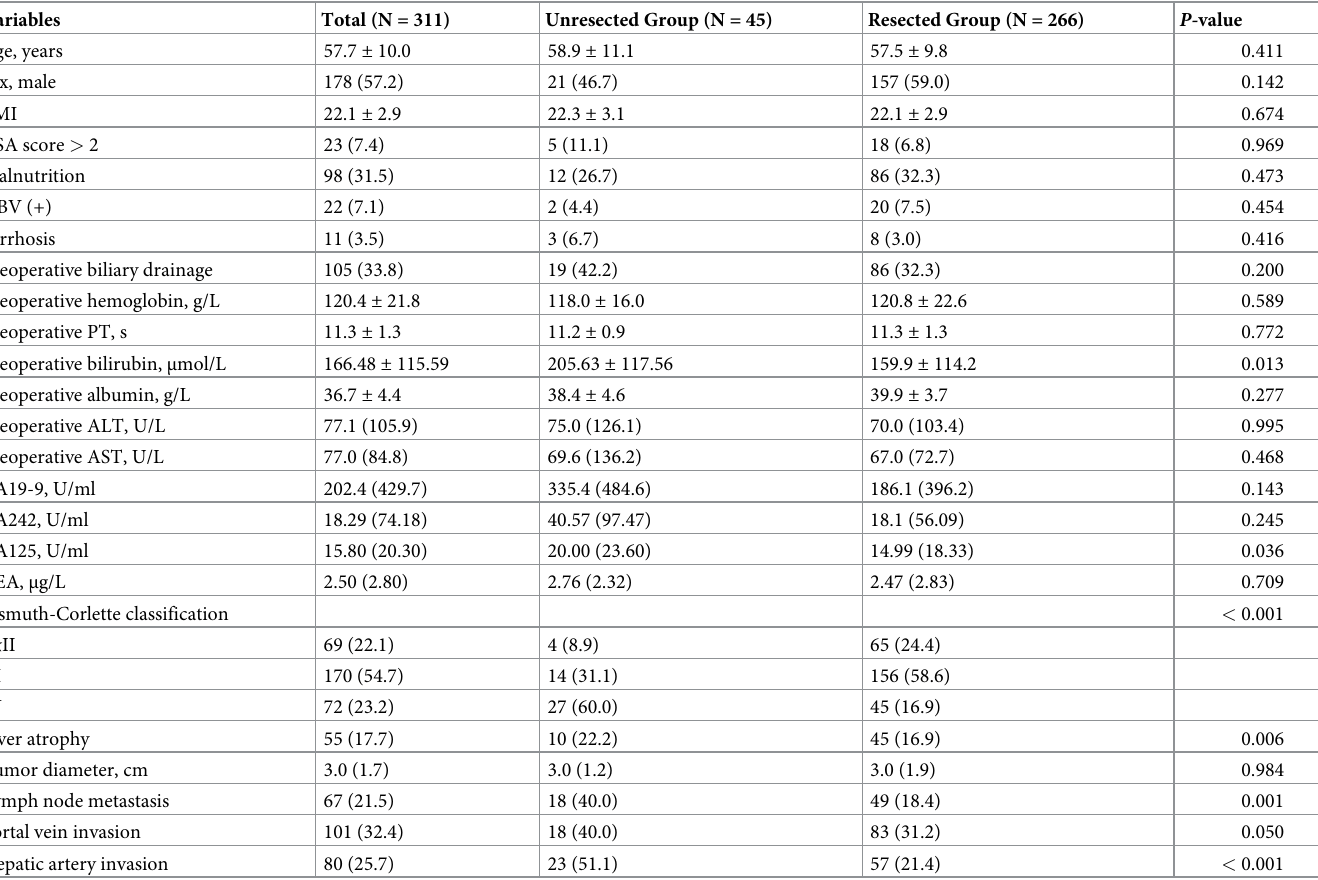
Table 2. Comparisons of preoperative variables between the unresected and resected